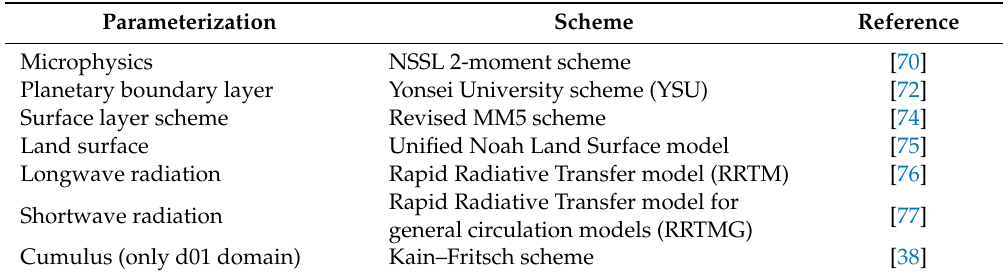
Table 1. Weather Research and Forecasting-Advanced Research (WRF-ARW) model